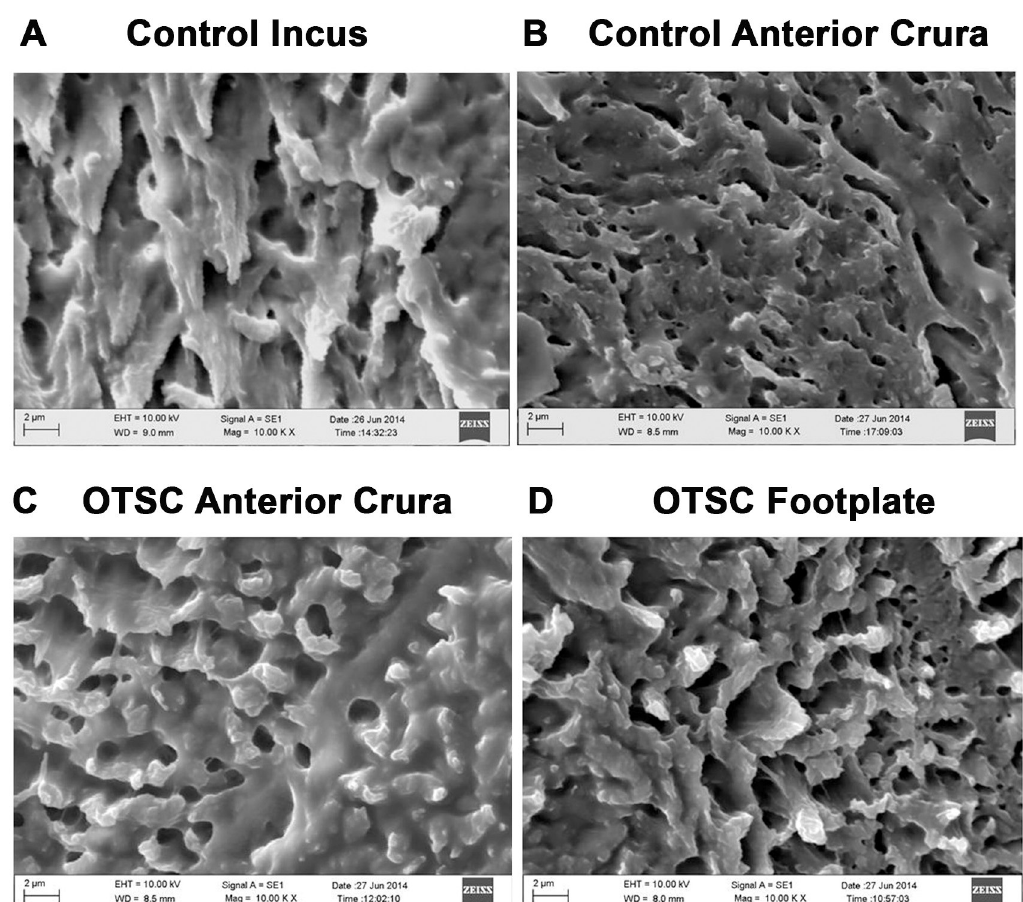
Fig 6. Scanning electron microscopy image of an otosclerotic stapes. The ultrastructure of the bone adopts a compact fibrillar morphological appearance in (A) incus bone from control, (B) anterior crura near otosclerotic zone in control stapes. Hollow honeycomb like structures were observed in (C) anterior crura near otosclerotic zone in patient’s stapes as well as in (D) stapedial footplate obtained from otosclerotic patient. Original magnification at 10000 times in a corresponding area of OTSC